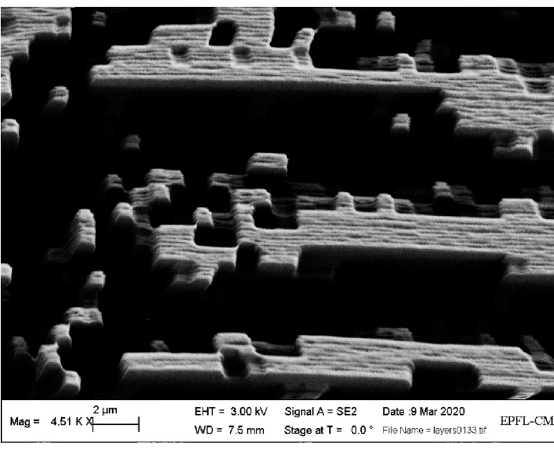
Figure 11: 1 µm by 1 µm pixels manufactured with high aspect ratio, whichdemonstratesthedegradationin3D printingqualityonedges more